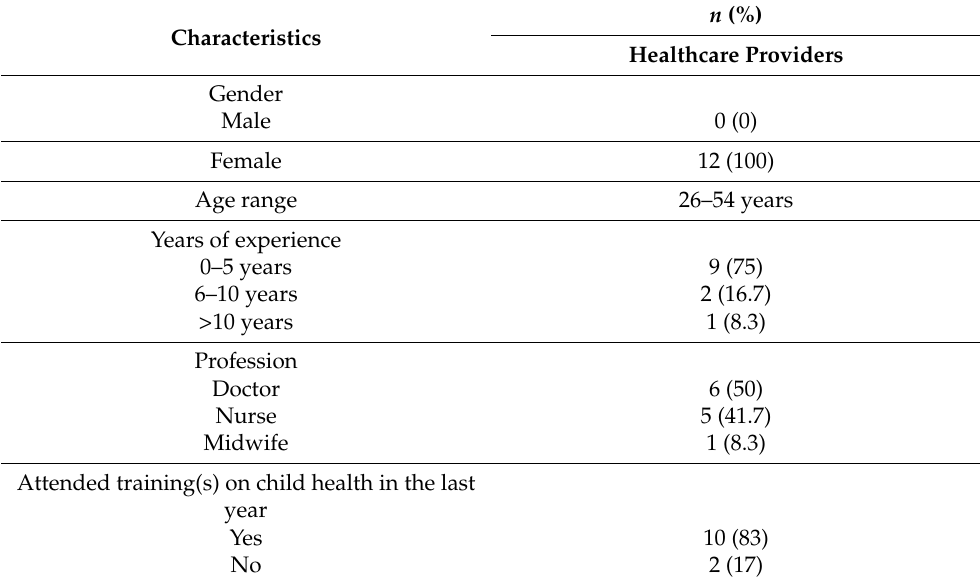
Table 3. Characteristics of healthcare